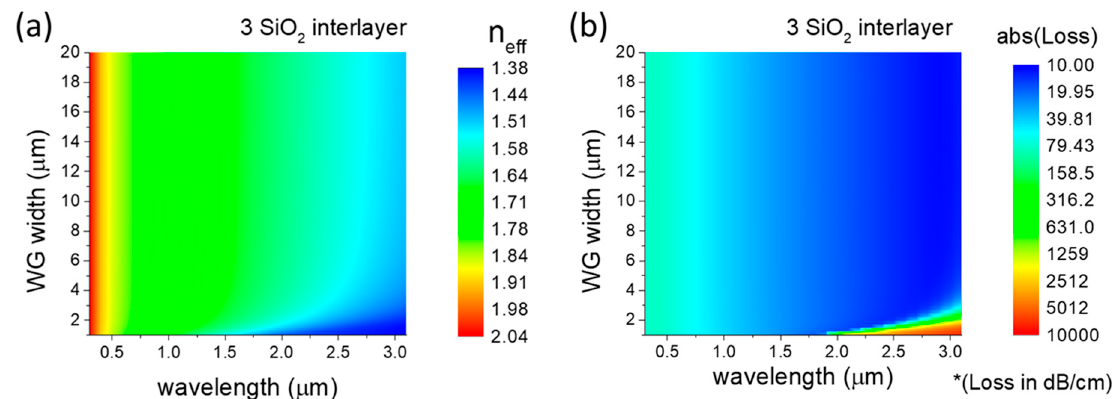
Figure 8. ( a ) Effective refractive index and ( b ) loss are plotted as a function of WG width and wavelength for 3 SiO 2 interlayers. The layer thickness was 125 nm for SiN layers and 90 nm for SiO 2 layers.